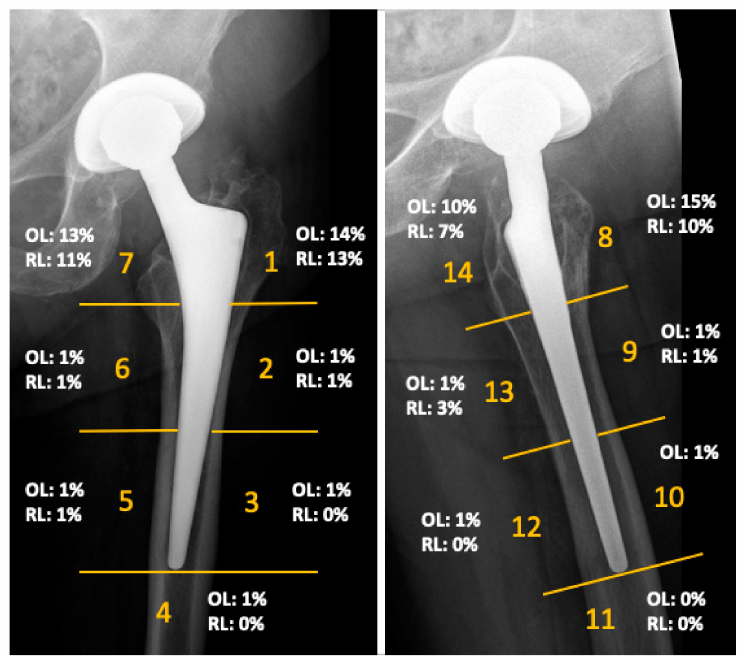
Figure 3. Results of the radiographic evaluation showing the distribution of radiolucent lines (RL) and osteolysis (OL), as seen on anteroposterior and lateral radiographs according to Gruen zones at a mean follow-up of 14